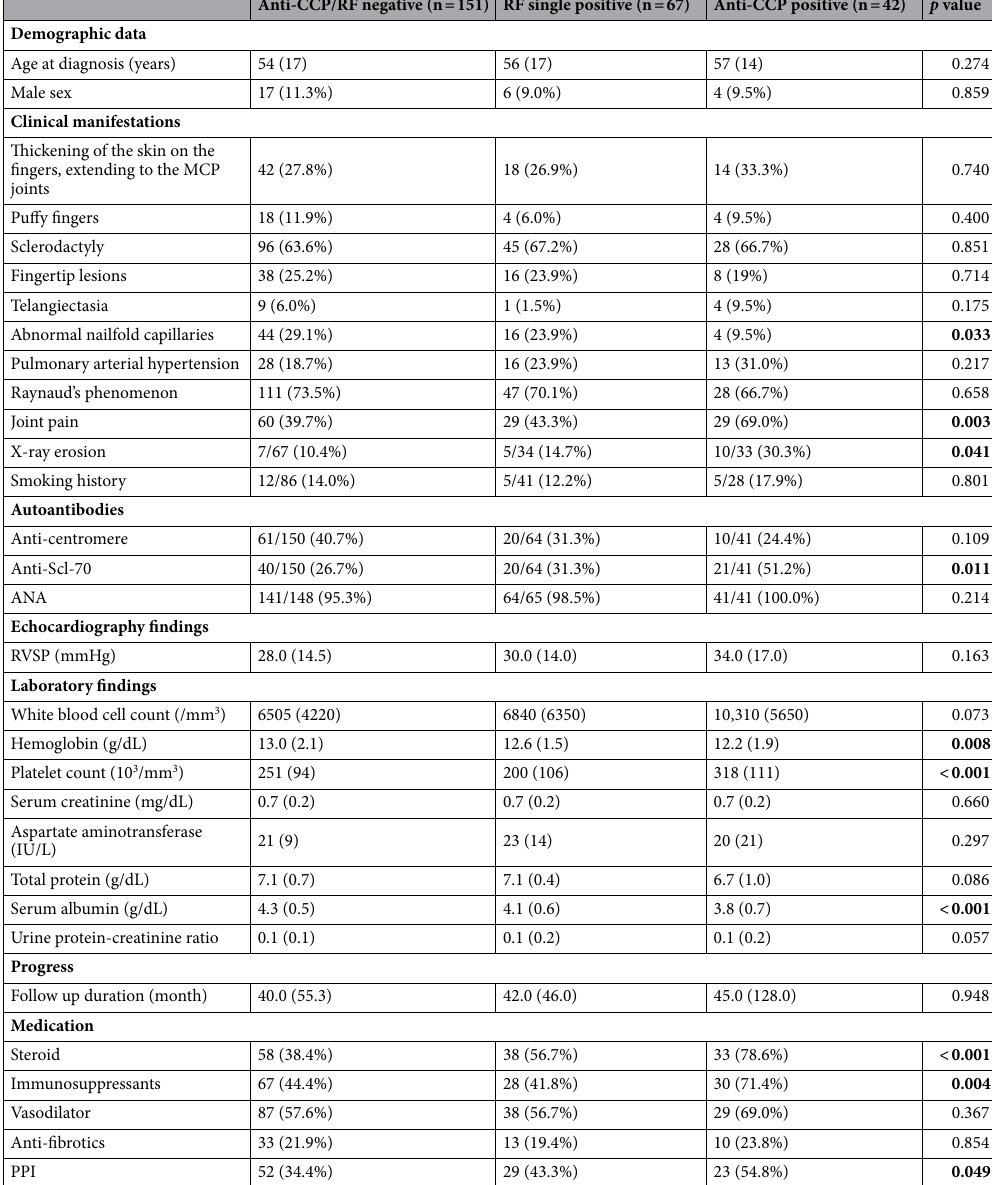
Table 3. Characteristics of patients with SSc based on anti-CCP antibody and RF positivity. Bold text indicates statistical significance. Values are expressed as medians (interquartile range, IQR) or n (%). SSc, systemic sclerosis; ILD, interstitial lung disease; MCP, metacarpophalangeal; ANA, antinuclear antibody; RVSP, right ventricular systolic pressure; PPI, proton pump